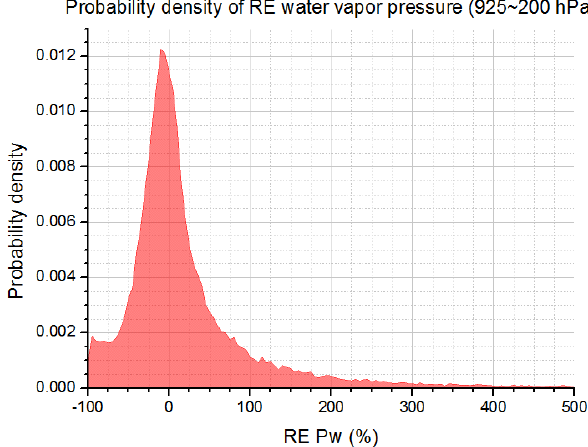
Fig. 4. Probability density of the relative error of water vapor pres- sure in the layers of 925 to